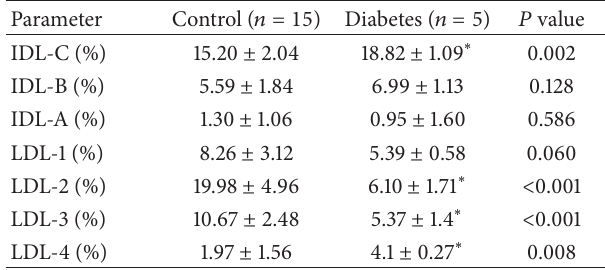
Table 2: LDL subfraction analysis in type 1 diabetic and control guinea